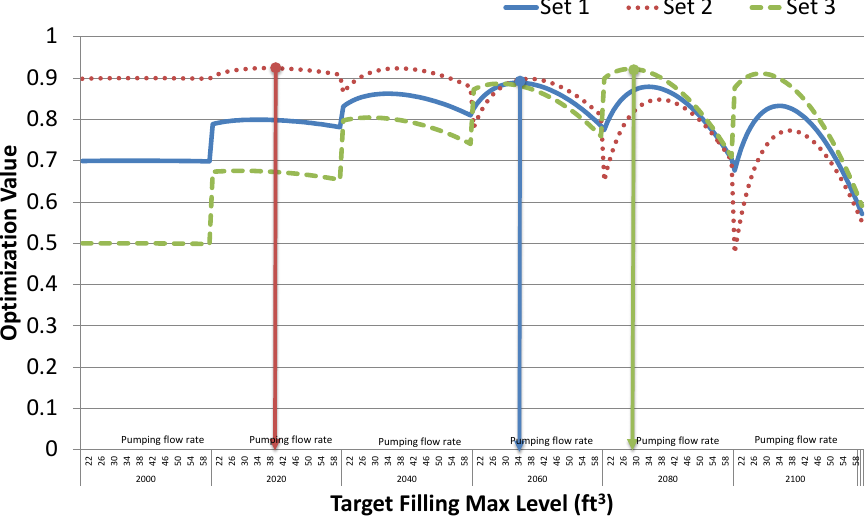
Figure 9. Effect of changing beta values on